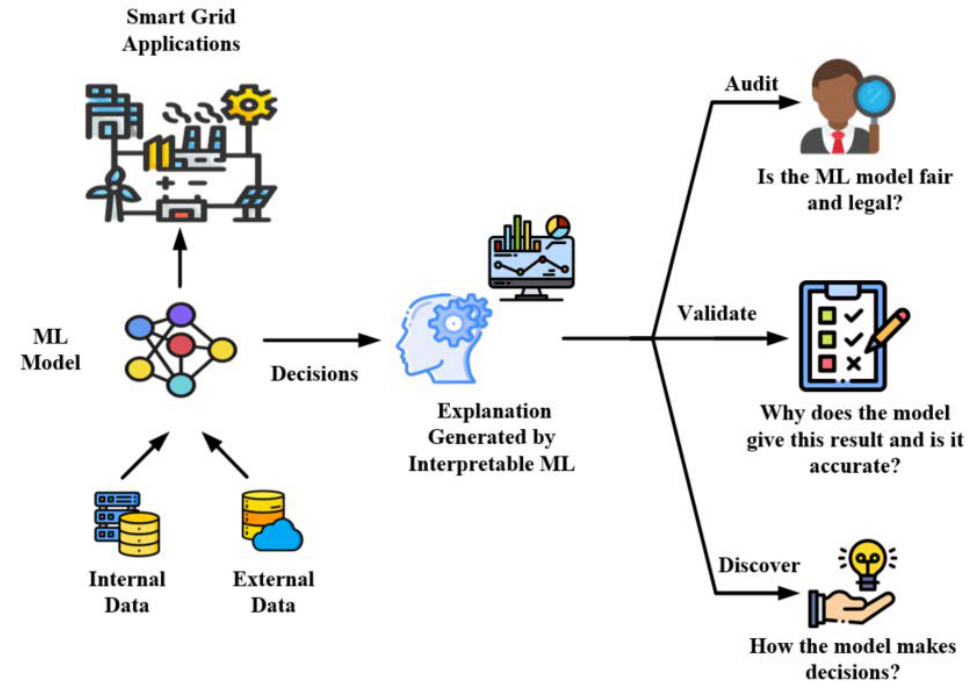
Figure 1. An illustration of interpretable ML in the smart